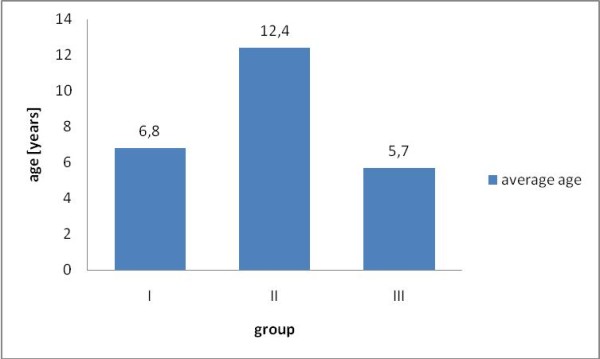
Avarage age of the dogs in particular groups. Statistical significant difference (p < 0.05) between group II (n = 23) and groups I (n = 53) and III (n = 12).